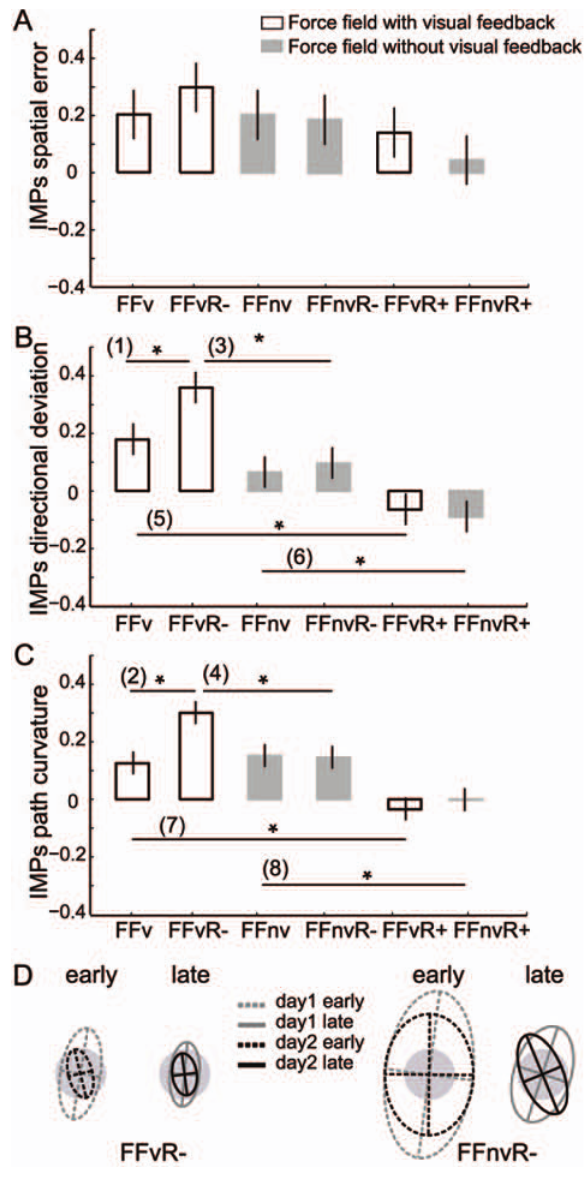
Figure 7. Effects of visuomotor rotation on force field retention. A–C, Improvement indices (IMPs) show increments in adaptations to force field from day1 to day2. Shown are mean IMPs of the first 40 trials for all groups. Vertical lines are 95% confidence interval of between-group differences in means. Numbered horizontal bars with asterisk indicate significant differences between paired groups (p , 0.05). D, Endpoint variability ellipses of all subjects in the matched double perturbation